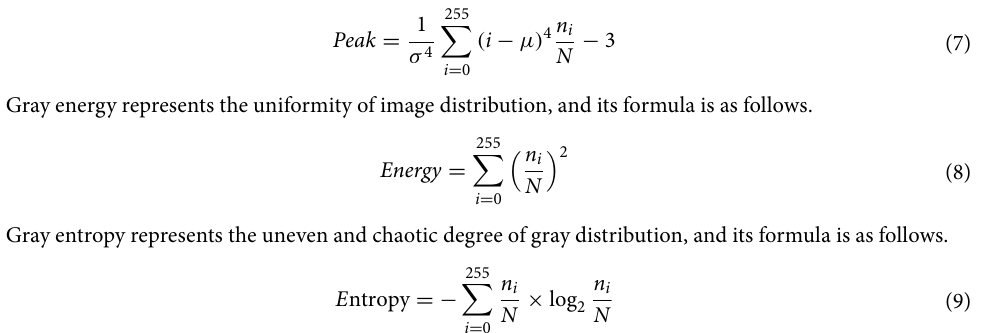
The gray peak indicates the degree to which the gray distribution is concentrated near the gray mean, and the formula is as follows.